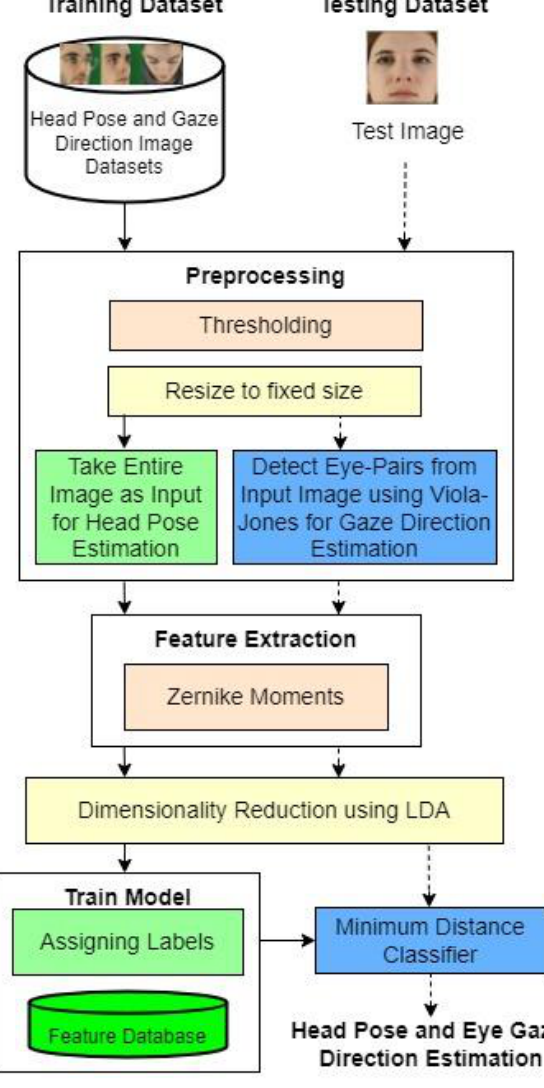
Figure 1. Overall head pose and gaze direction estimation system.